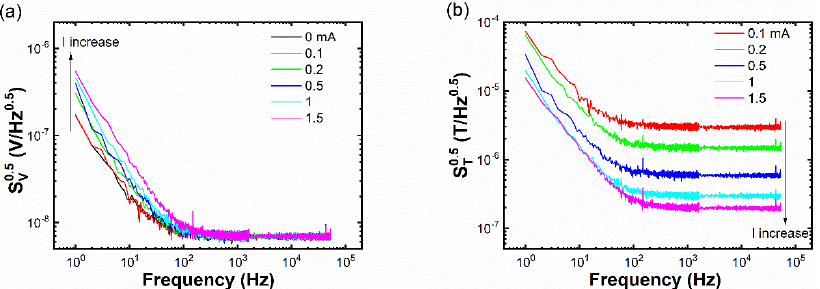
Figure 2. ( a ) Noise spectra and ( b ) field detectability spectra of the 4 nm thick Fe 29 Pt 71 thin-film sample under various input currents.